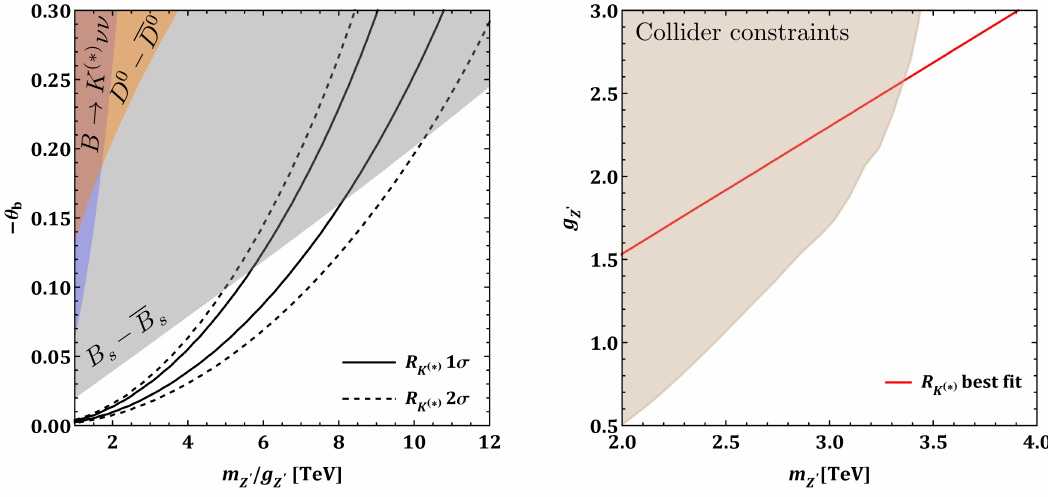
/g , − θ } which is compatible with the Z 0 Z 0 b − B mixing, D 0 − D 0 mixing and B → K ( ∗ ) νν at s s Z 0 is set to be b